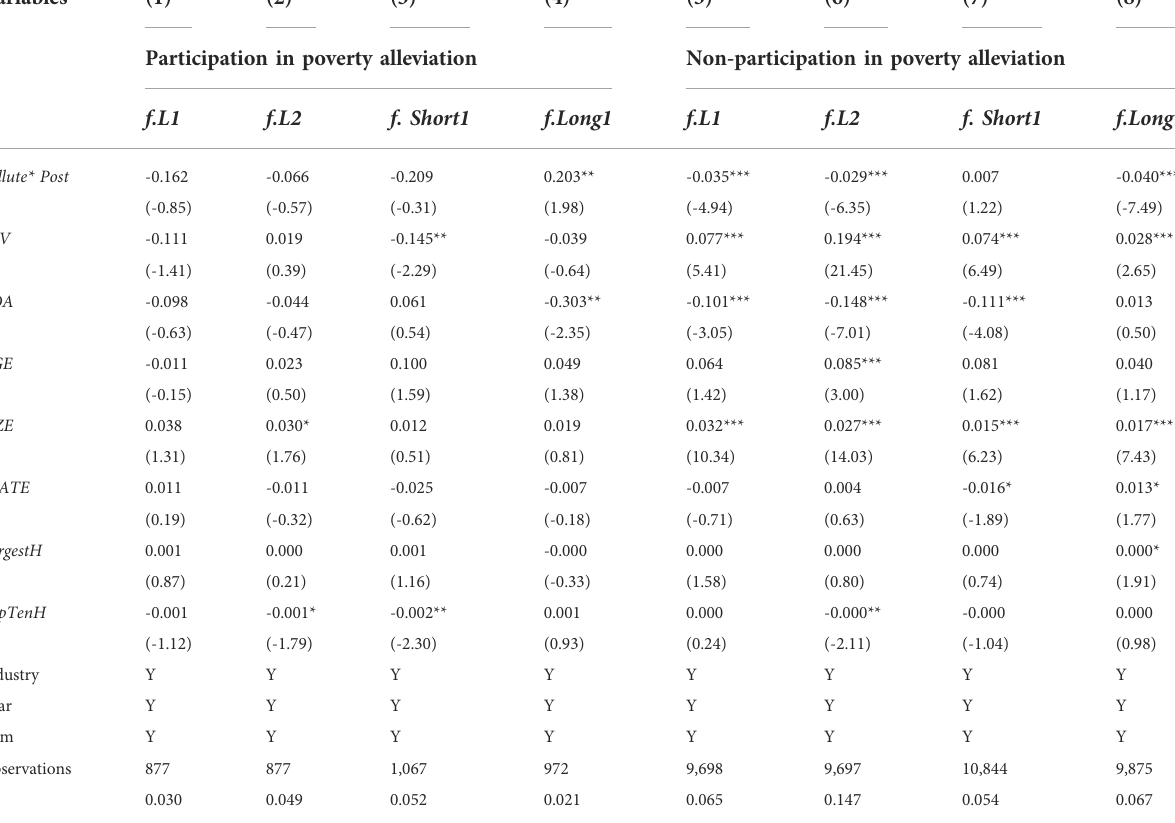
TABLE 12 T+1 period of Corporate Participation in Poverty